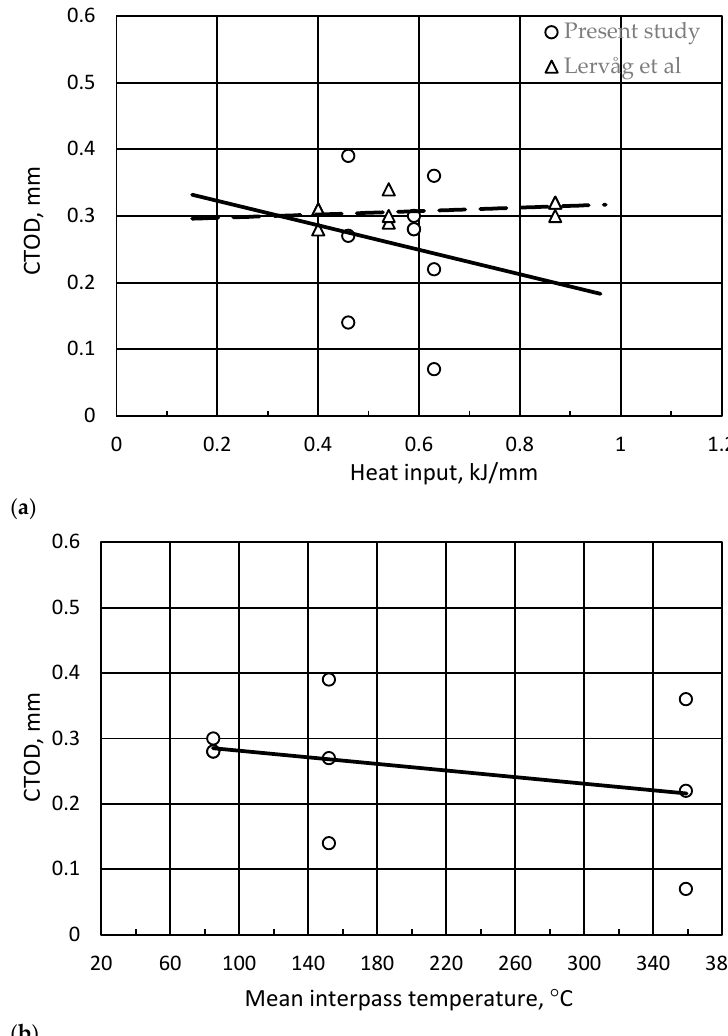
Figure 5. CTOD fracture toughness; tested at − 46 °C. Data for − 20 °C taken from Lervåg et al. [19]. ( a ) Effect of mean heat input, and ( b ) effect of mean interpass temperature (left).